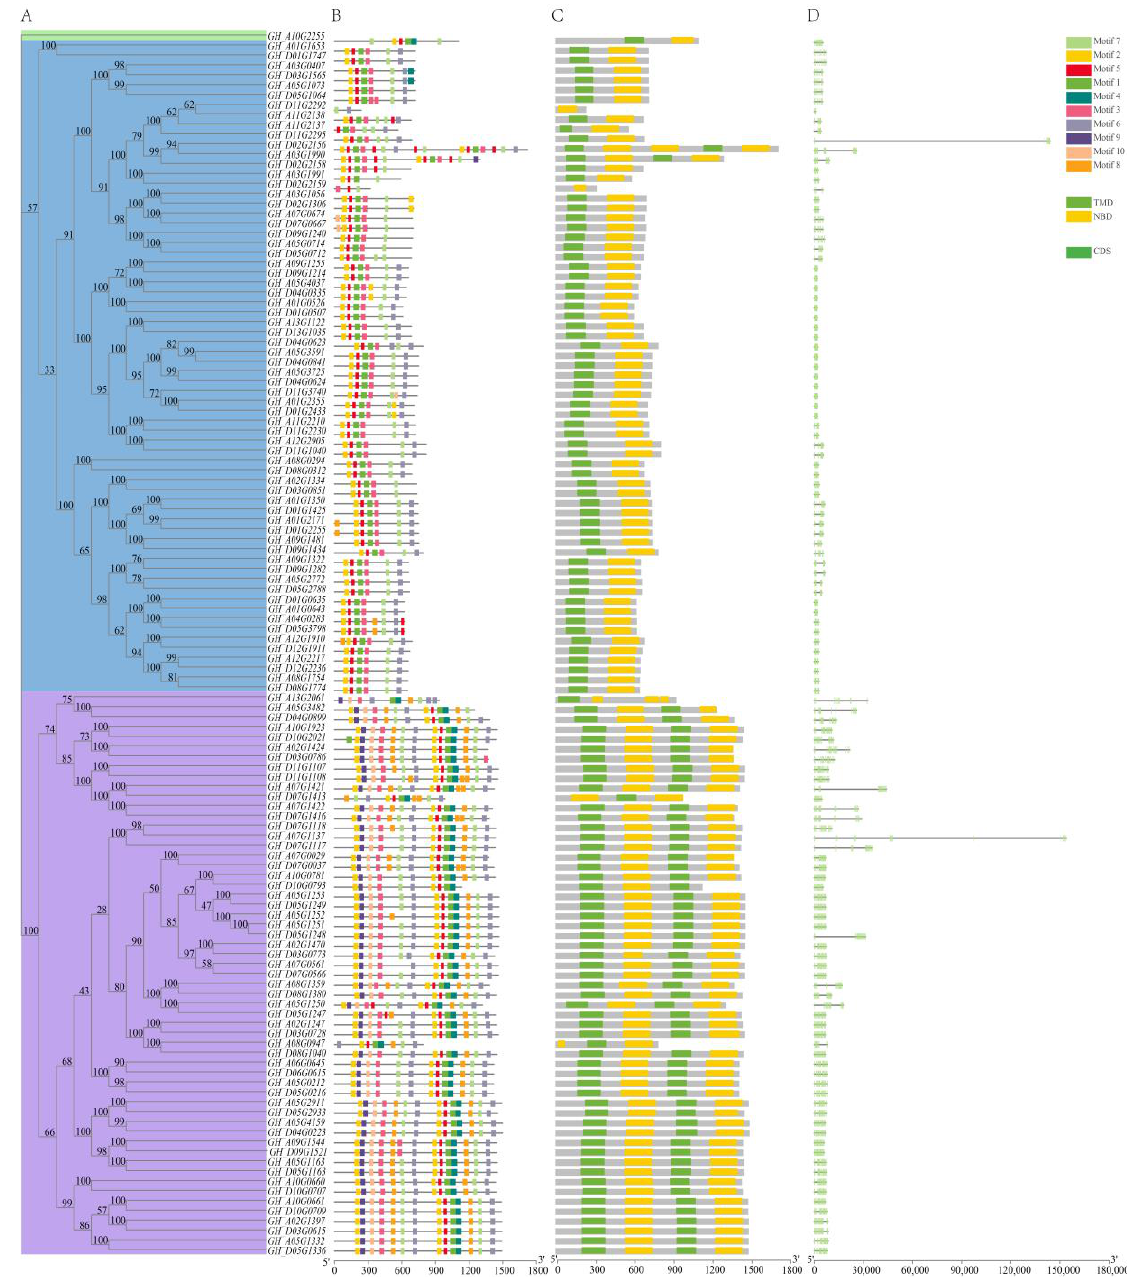
Figure 2. The schematic diagram of phylogenetic tree ( A ), conserved motif ( B ), domain ( C ) and exon/intron construction ( D ) of 124 ABCG members in G. hirsutum . ( A ) A total of 124 ABCGs in G. hirsutum were clustered into 3 clades shown in green, blue and purple, respectively. ( B ) and ( C ) The motifs or domains are indicated by colored boxes correspondingly. ( D ) The exon and intron of ABCGs are denoted by green box and gray line.